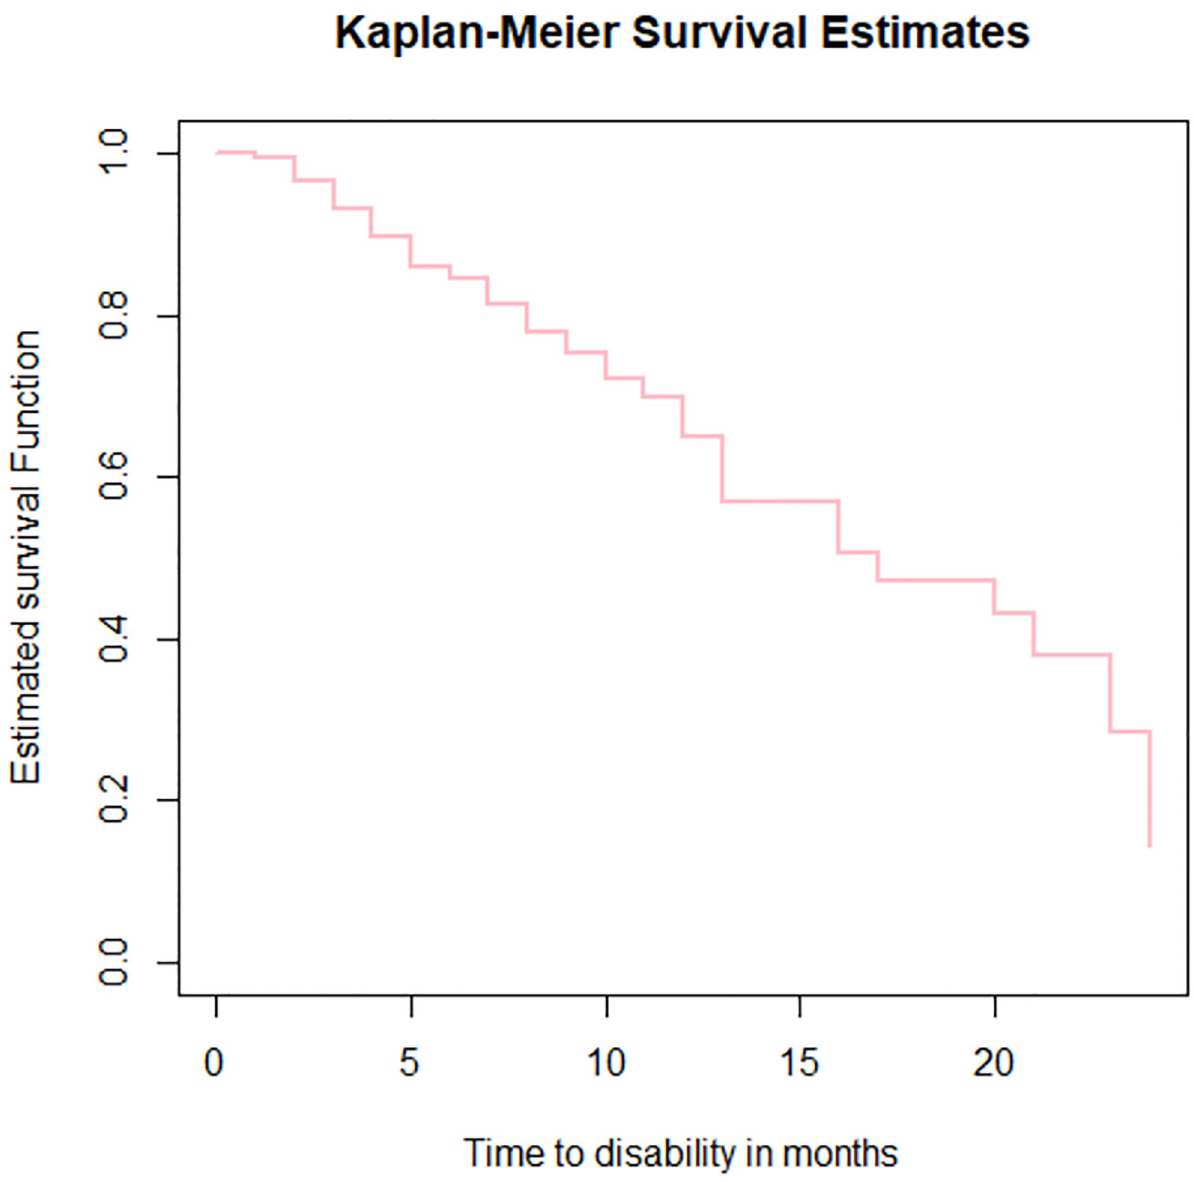
Fig 1. The K-M plot of the survival function for leprosy patients dataset, LPAC, 2015–2019.